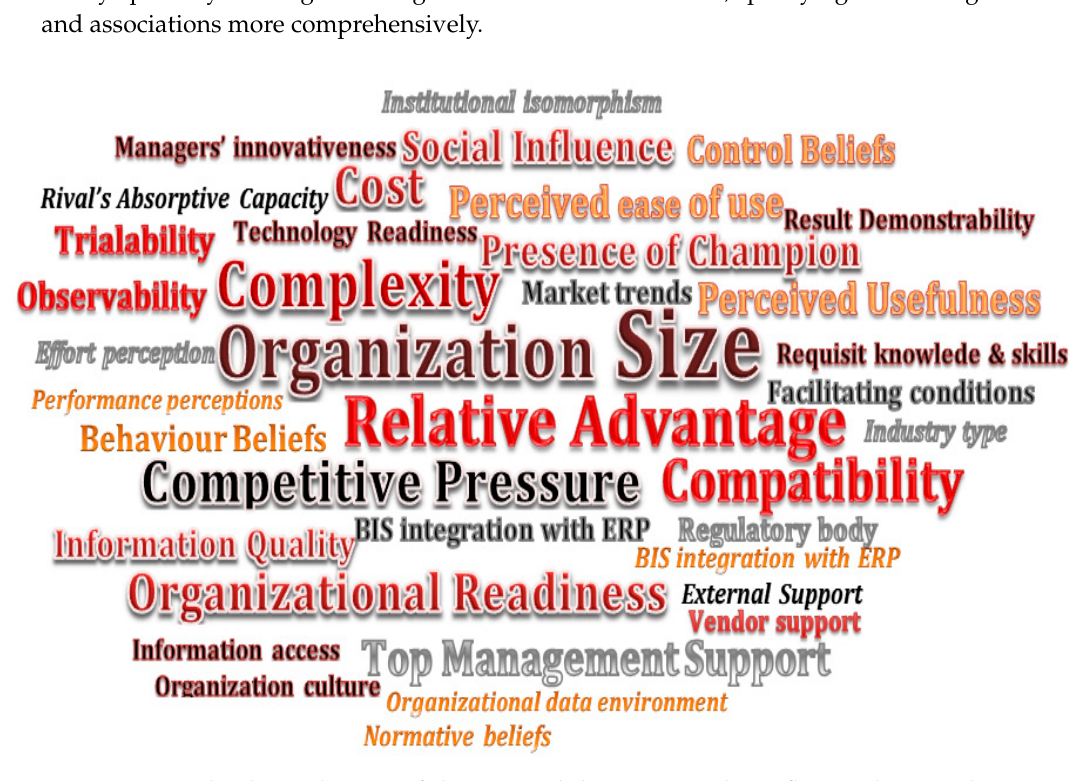
Figure 7. Tag cloud visualization of the potential determinants that influence the BIS adoption and acceptance.